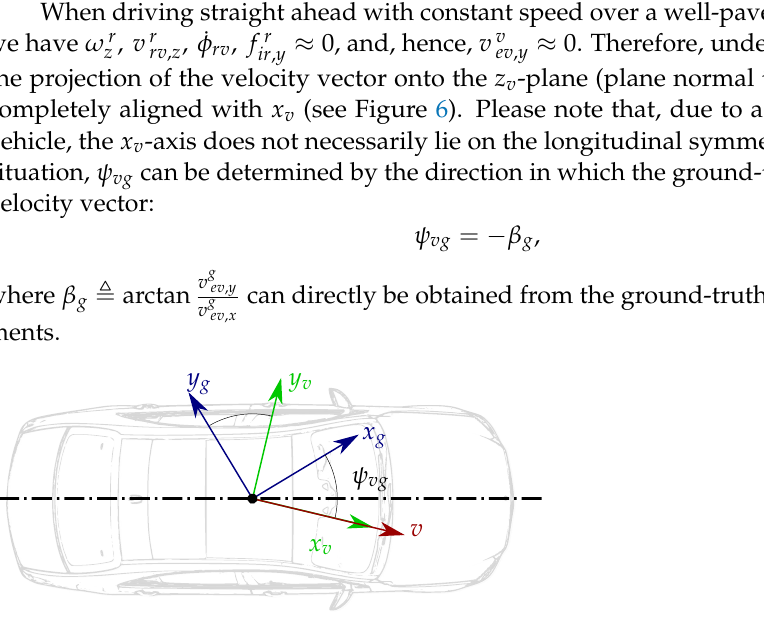
Figure 6. Velocities of a vehicle while driving straight ahead with constant speed over a well-paved horizontal